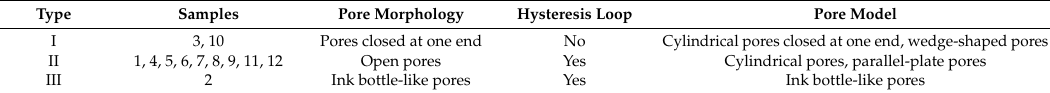
Figure 4. Three types of adsorption-desorption curves of Bakken samples. ( a ) Type A; ( b ) Type B; ( c ) Type C. Table 2. Ideal pore model division of Bakken formation samples.